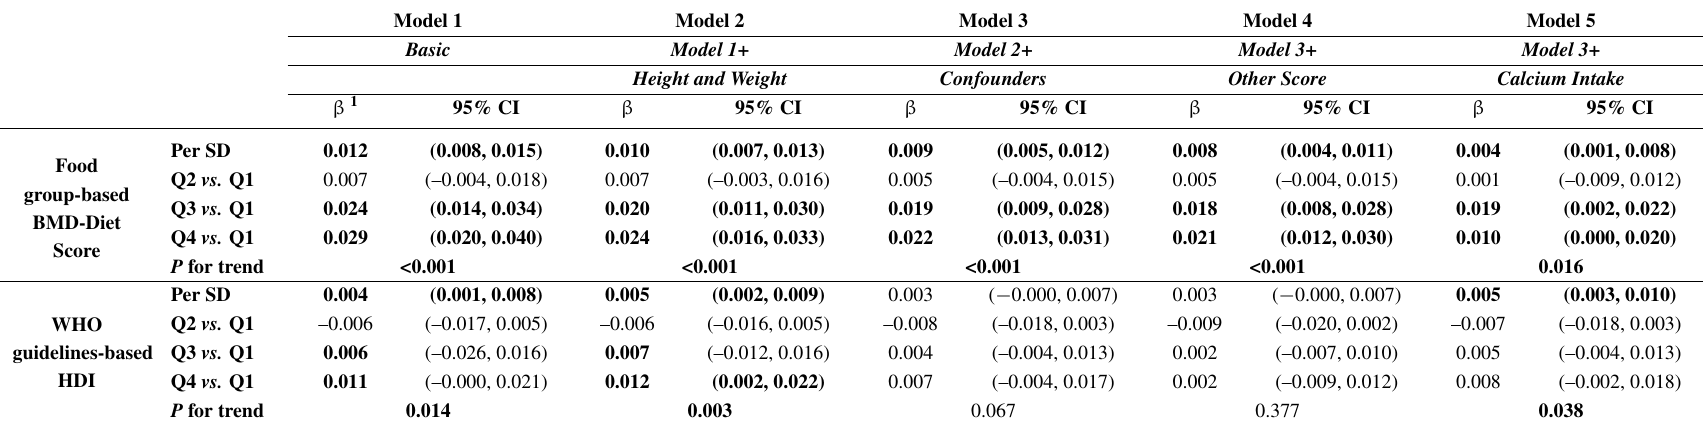
Table 3. Associations between the BMD-Diet Score or Healthy Diet Indicator and femoral neck BMD, using linear mixed